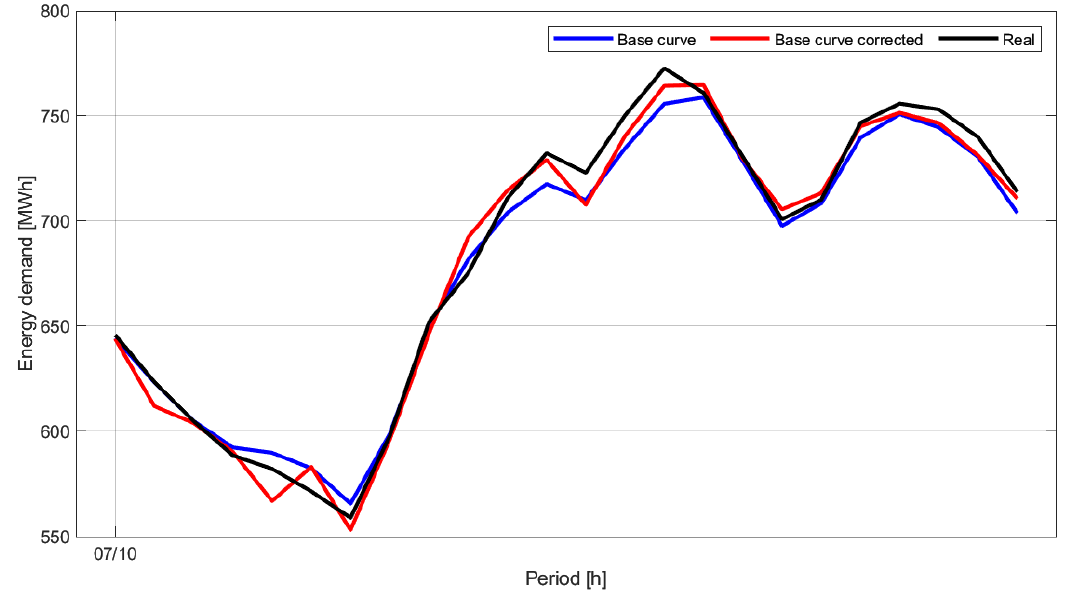
Figure 14. Sample for a base curve of Market 1.